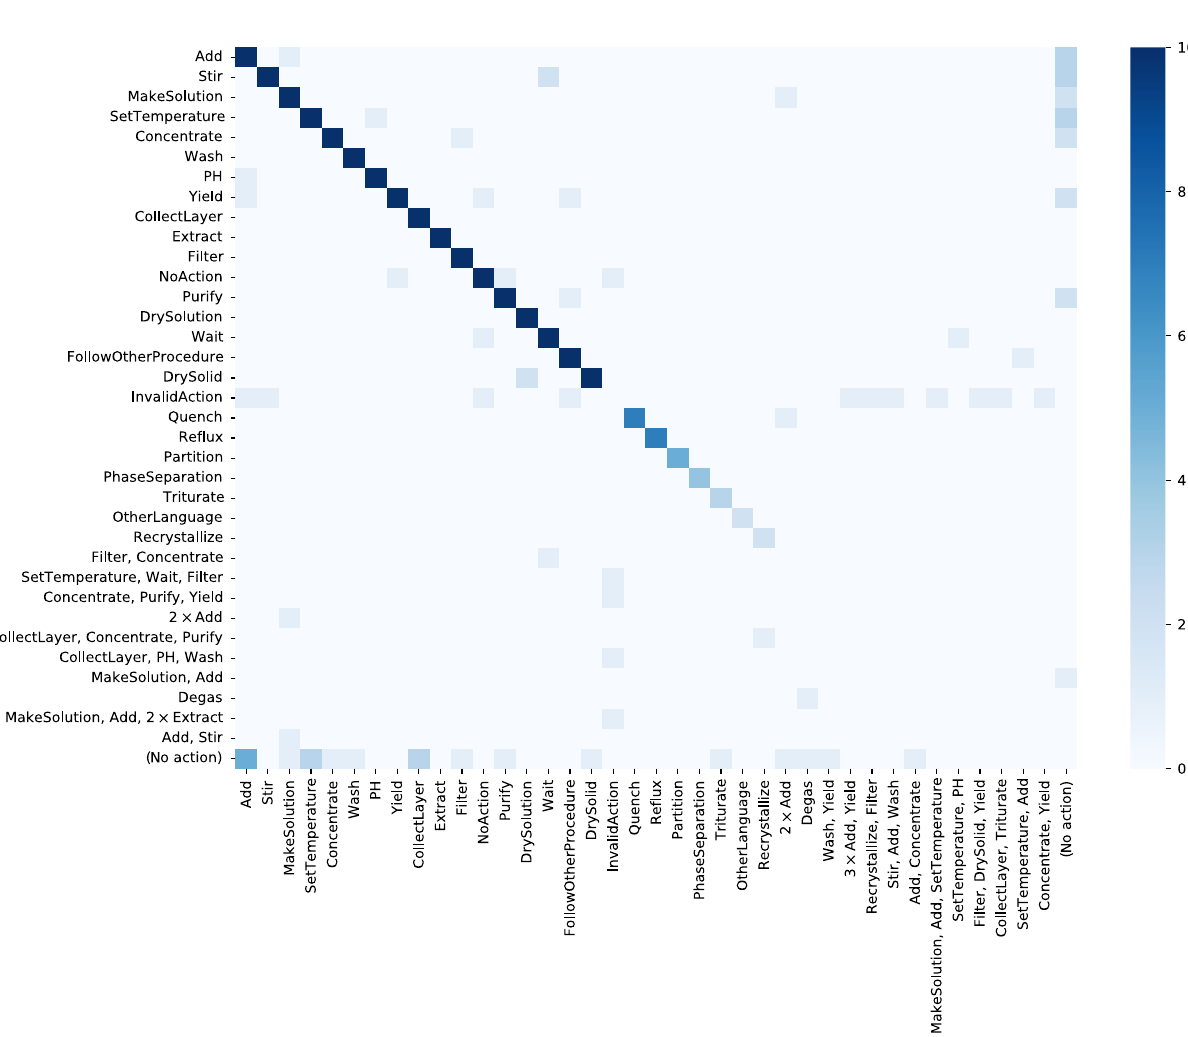
Fig. 1 Visualization of the correctness of predicted action types. The action types predicted by the transformer model (labels on the x- axis) are compared to the actual action types of the ground truth (labels on the y -axis). This fi gure is generated by fi rst counting all the correctly predicted action types (values on the diagonal); these values correspond to the column "Type match'' of Table 5. Then, the off-diagonal elements are determined from the remaining (incorrectly predicted) actions. Thereby, the last row and column gather actions that are present only in the predicted set or ground truth, respectively. For clarity, the color scale stops at 10, although many elements (especially on the diagonal) exceed this